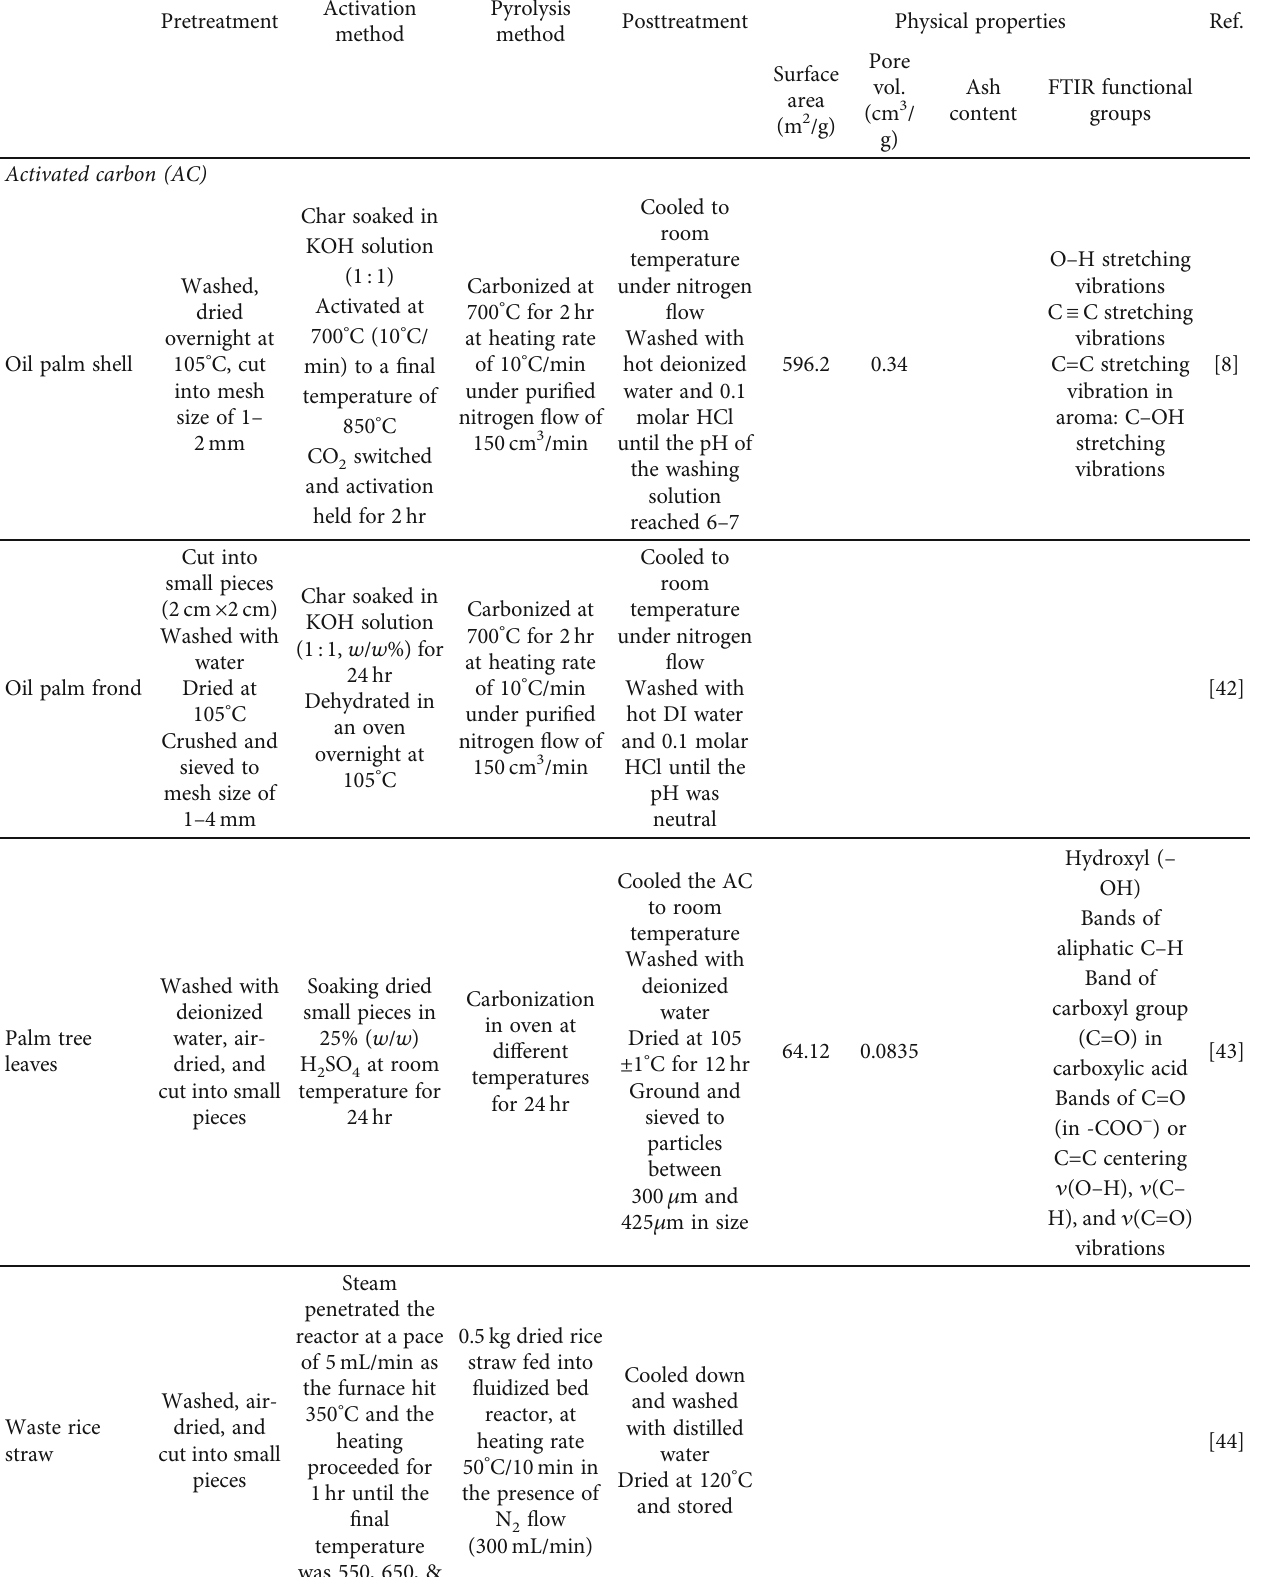
Table 1: Preparation techniques for AC and BC utilizing various